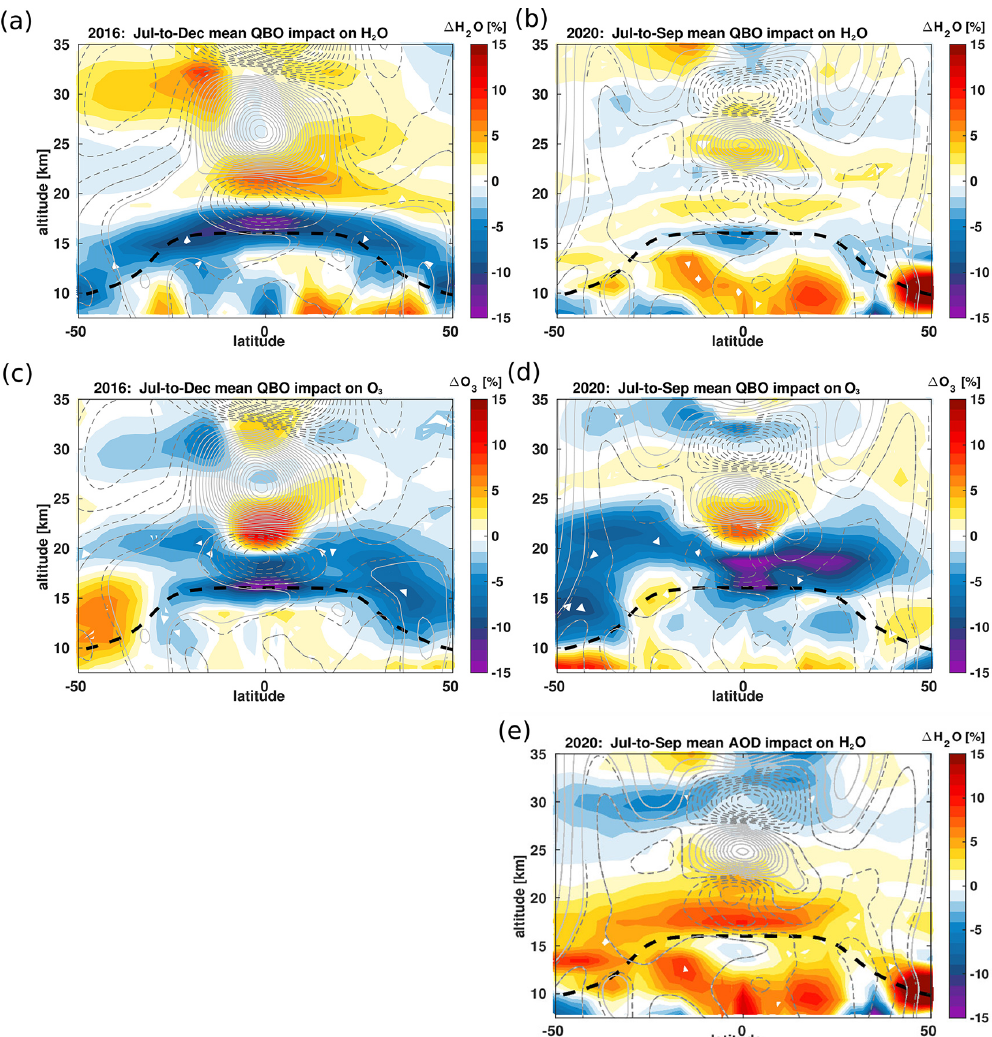
Figure 3. Impact of the QBO disruption on the zonal mean lower-stratospheric H 2 O (a, b) and O 3 (c, d) anomalies from MLS satellite observations averaged from July to December for 2016 (a, c) and from July to September for 2020 (b, d) . In addition, the impact of the 2020 Australian wildfires on the zonal mean lower-stratospheric H 2 O is shown (e) . All panels show the percentage change relative to 2005–2014 monthly mean mixing ratios as a function of latitude and altitude. The impact of the QBO disruptions and the Australian wildfire on the stratospheric trace gases is derived from the multiple regression fit as the difference between the residual ( (cid:15) in Eq. 1) without and with explicit inclusion of the QBO signal. The black dashed horizontal line indicates the tropopause from the ERA5 reanalysis. The monthly averaged zonal mean zonal wind component, U (ms − 1 ), from the ERA5 reanalysis is overlaid as solid grey (westerly wind) and dashed grey (easterly wind)